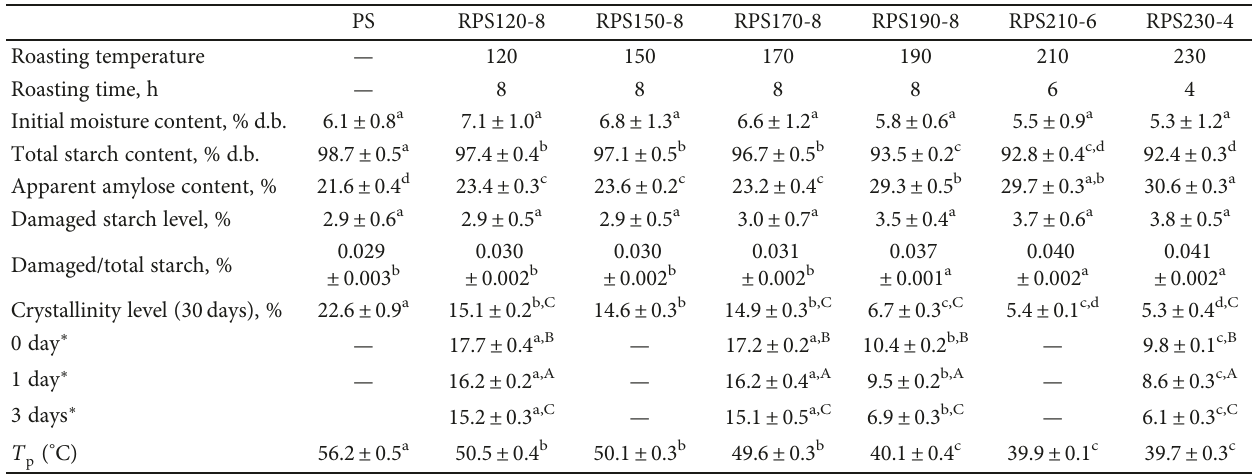
Table 1: Proximate physicochemical features of tested potato starch (PS) (30% w / w ) roasted at di ff erent temperatures (120, 150, 170, 190, 210, and 230 ° C) for the time corresponding to the highest solubility values for each tested roasting temperature. The corresponding gelatinization peak temperature ( T ) is also p